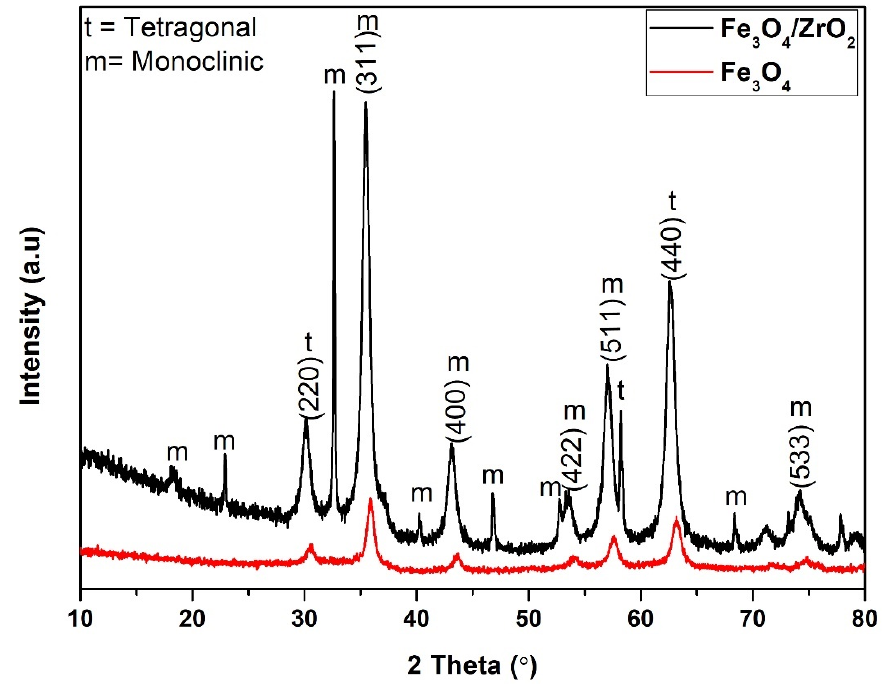
Figure 1. X-ray diffraction patterns for Fe 3 O 4 nanoparticles and Fe 3 O 4 -ZrO 2 nanocomposite.